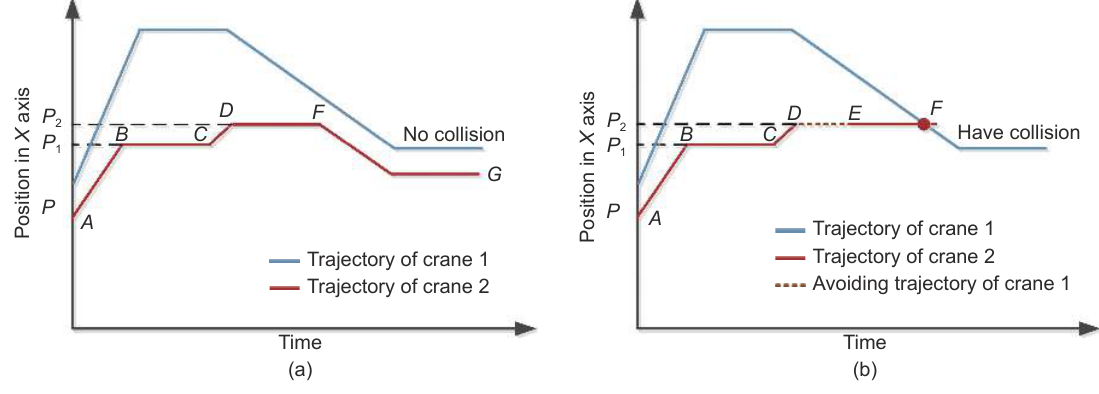
Fig. 5 Example of a twin-crane interference with idle